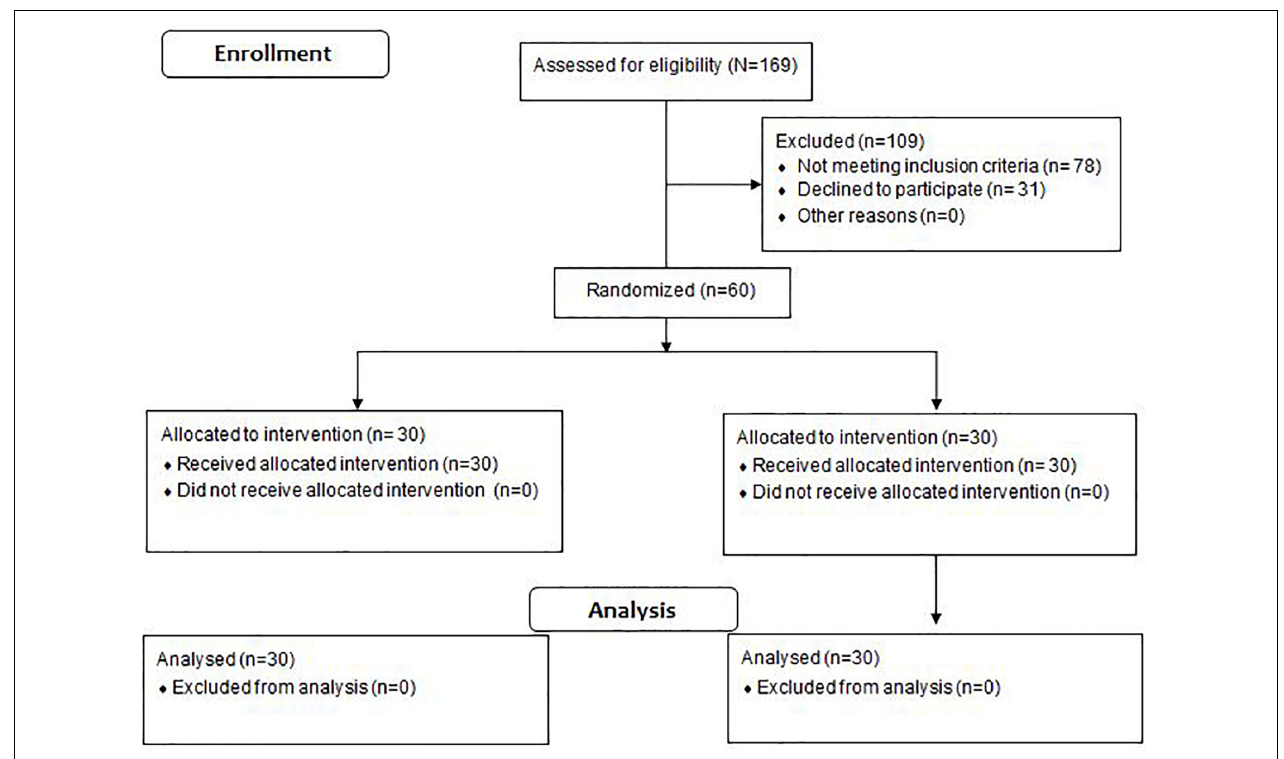
FIGURE 1 | Flow diagram of the randomized controlled